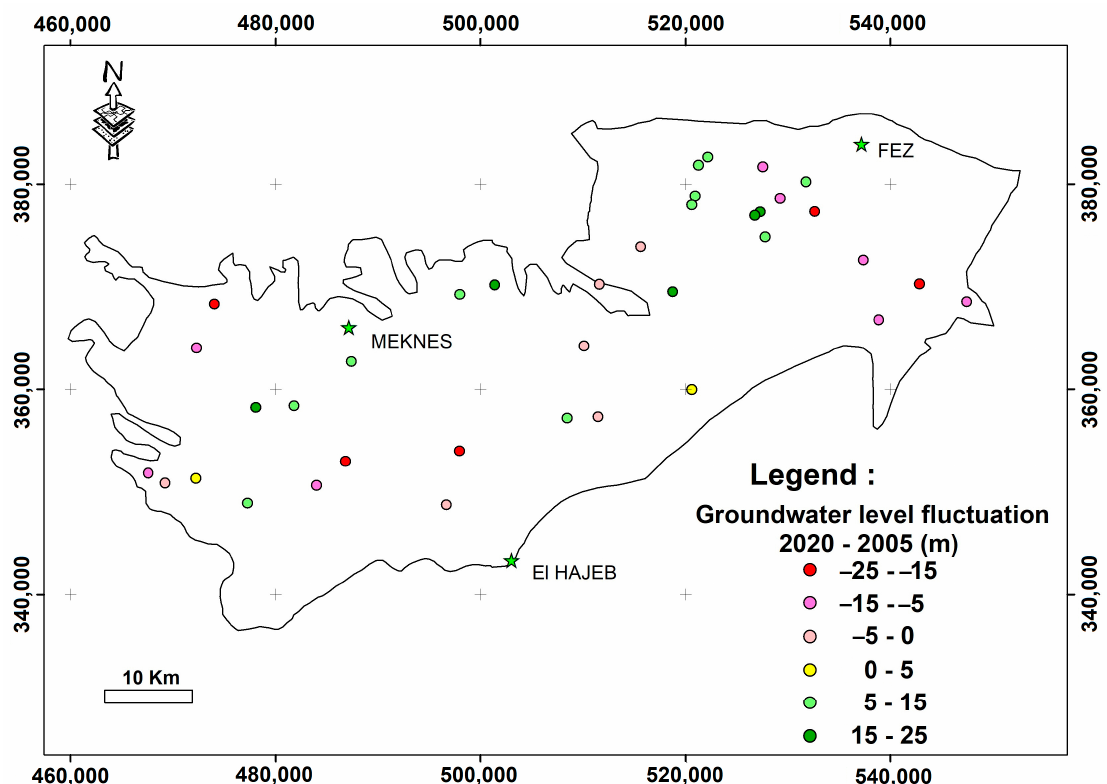
Figure 13 . Map of wells according to the value of the groundwater level difference between 2005 and 2020 . and 2020.